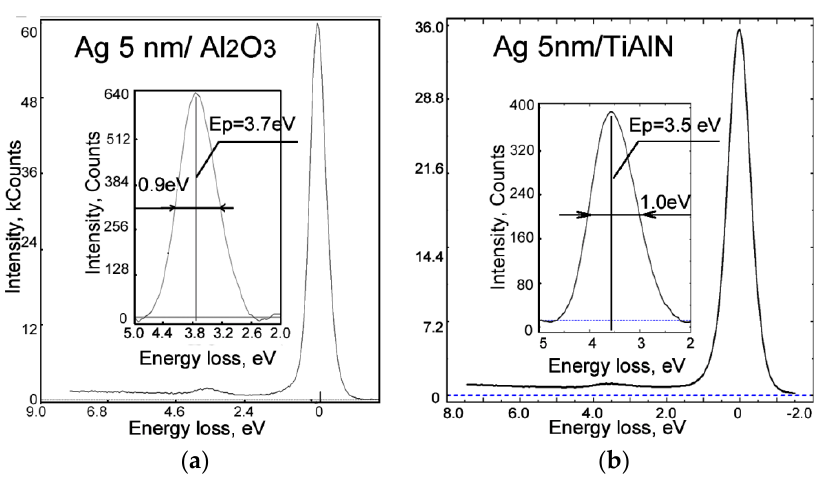
Figure 1. Electron energy loss spectroscopy (EELS) of Ag layers in 5 nm Ag/20 nm Al 2 O 3 ( a ) and 5 nm Ag/24 nm TiAlN ( b ) multilayer coatings.